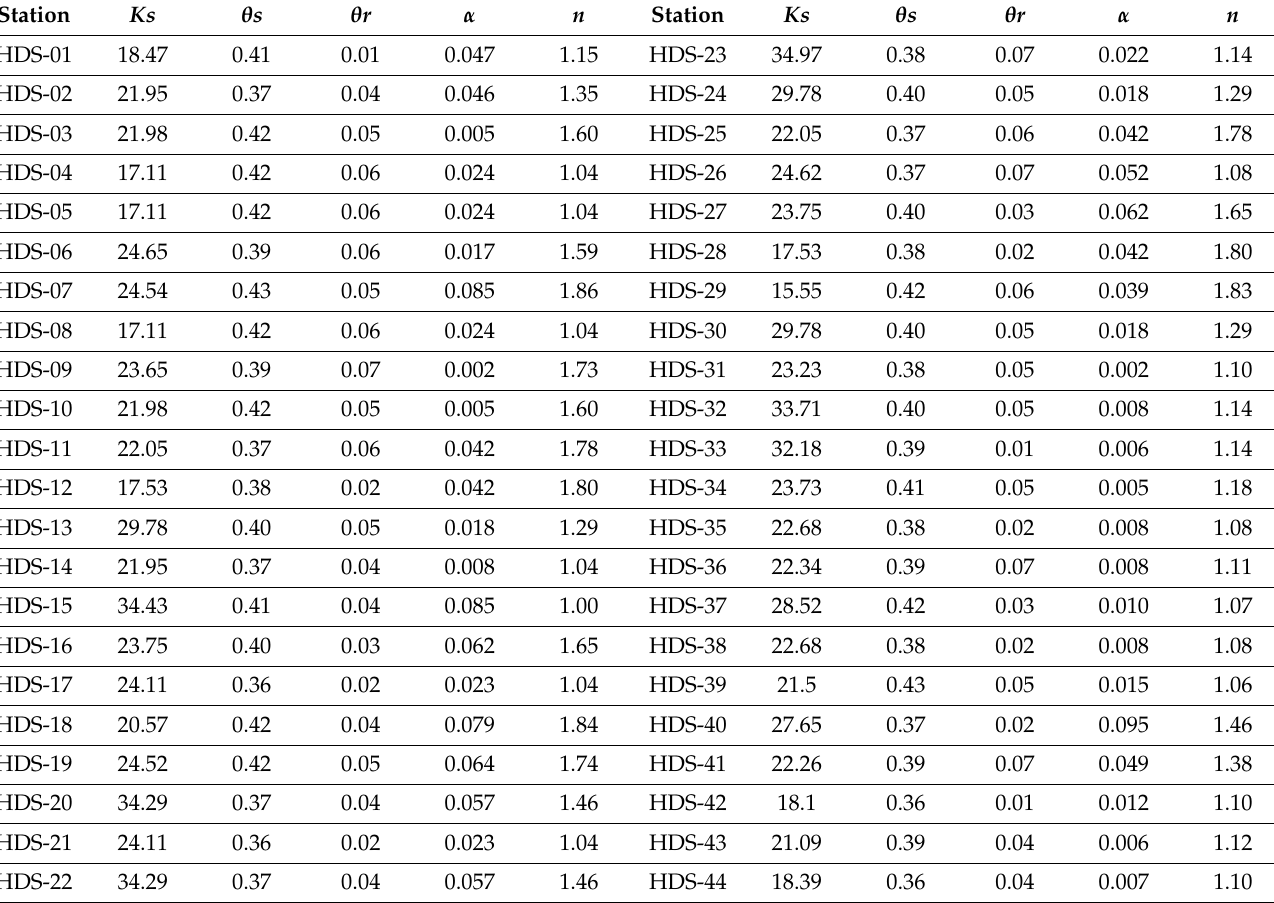
Table 4. SHPs of 44 HDS sites corresponding to the best iteration (minimum